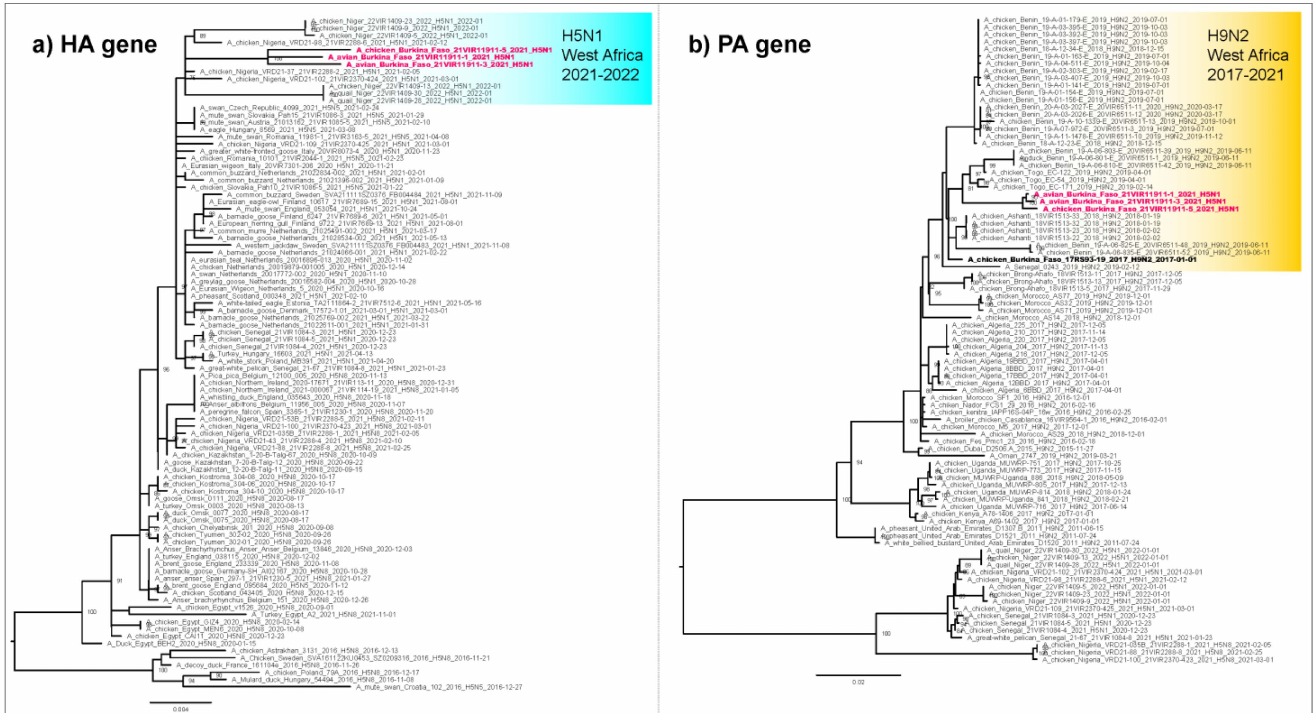
Figure 2. Maximum likelihood phylogenetic trees of the hemagglutinin (HA) and polymerase acidic (PA) genes. ( a ) Maximum likelihood phylogenetic tree of the HA gene. The light blue box shows the cluster of H5N1 viruses identified in West Africa in the period 2021–2022; the HPAI H5N1 viruses from Burkina Faso are highlighted in bold pink. ( b ) Maximum likelihood phylogenetic tree of the PA gene. The yellow box shows the cluster of H9N2 viruses identified in West Africa in the period 2017–2021; the HPAI H5N1 viruses from Burkina Faso are highlighted in bold pink; the 2017 H9N2 virus from Burkina Faso is highlighted in bold black. The trees were inferred using IQTREE v1.6.6. Ultrafast bootstrap supports higher than 75 are indicated next to the